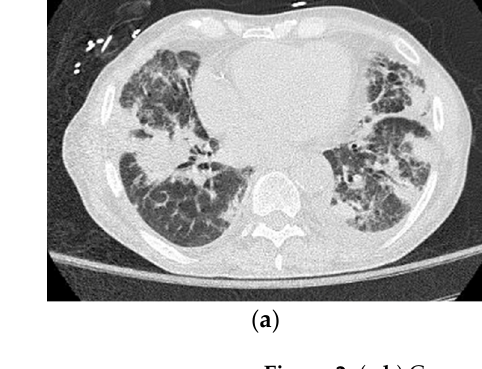
Figure 2. ( a , b ) Computerized tomography of the thorax demonstrating patient’s irregular pulmonary infiltrates, with peripheral cystic changes (honeycombing) and traction bronchiectasis. Table 1. Hematological laboratory values of the patient (BM bx = bone marrow biopsy; PB = peripheral blood).